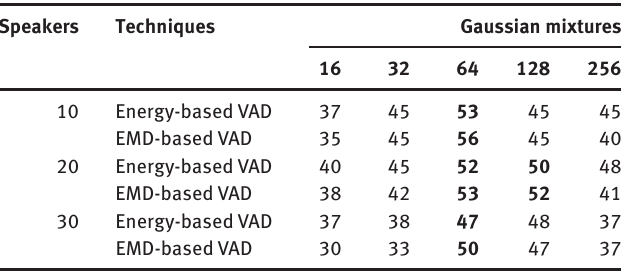
Table 2. Experimental results illustrating performance comparison between energy based VAD and EMD based VAD in a speaker identification scenario in terms of percentage identification rate (%